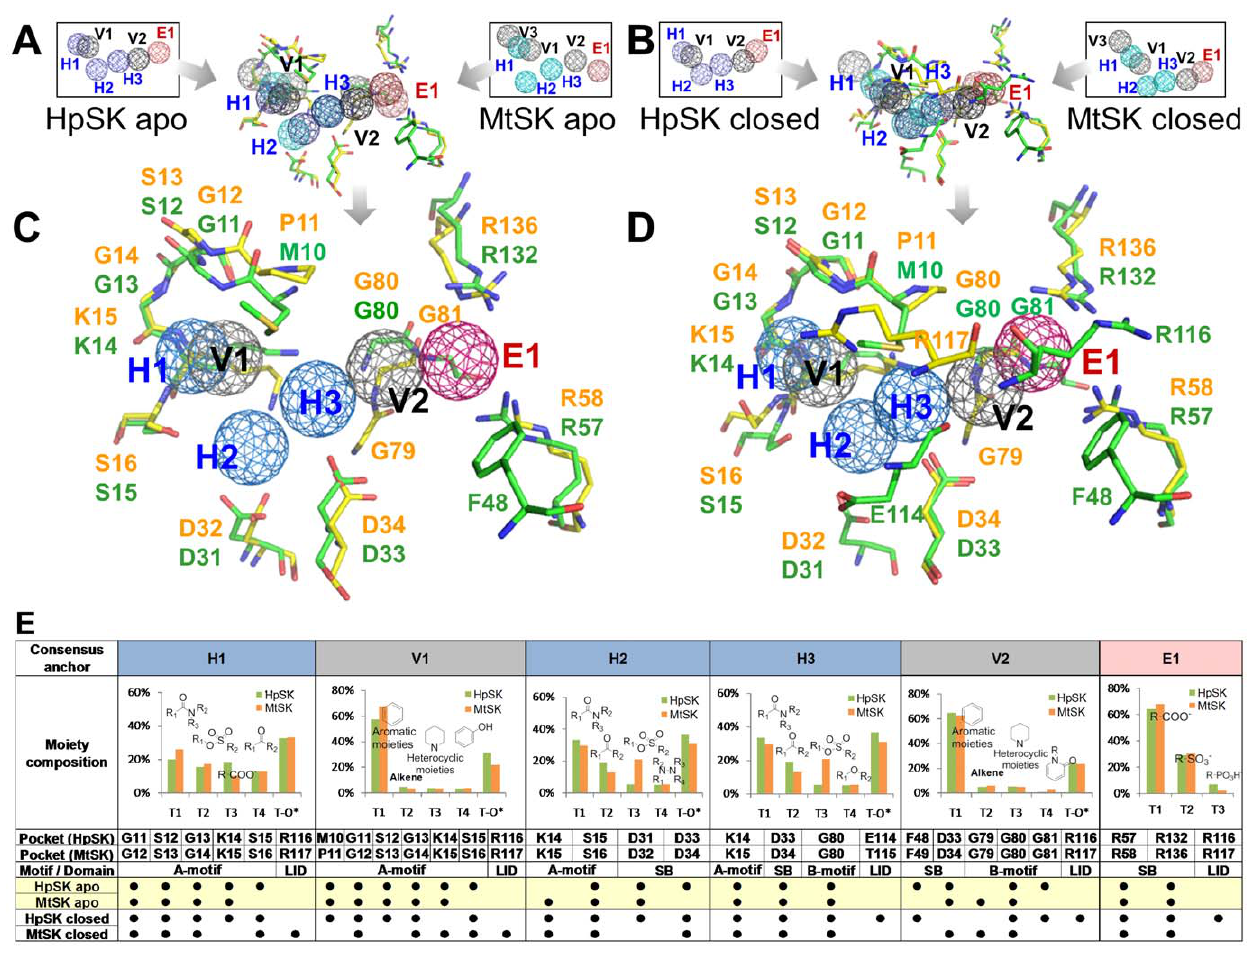
Figure 2. Shikimate kinase CoreSiMMaps. (A) Superimposed apo-form anchors of HpSK and MtSK. (B) Superimposed closed-form anchors of HpSK and MtSK. (C) The apo-form CoreSiMMap and (D) the closed-form CoreSiMMap include six consensus anchors derived from consensus anchors (A) and (B), respectively. Each consensus anchor shares conserved residues between HpSK and MtSK and has the same interaction type of binding environment. (E) Features of the six consensus anchors of the apo-form CoreSiMMap. Each of the T groups (T1–T4) represents a given chemical moiety and T-O* indicates other chemical groups. H1, V1, and H2 are situated at the ATP-binding site, while H3, V2, and E1 are at the shikimate- binding site. Each consensus anchor includes conserved interacting residues ( N ) and the major chemical moieties of the compound candidates.